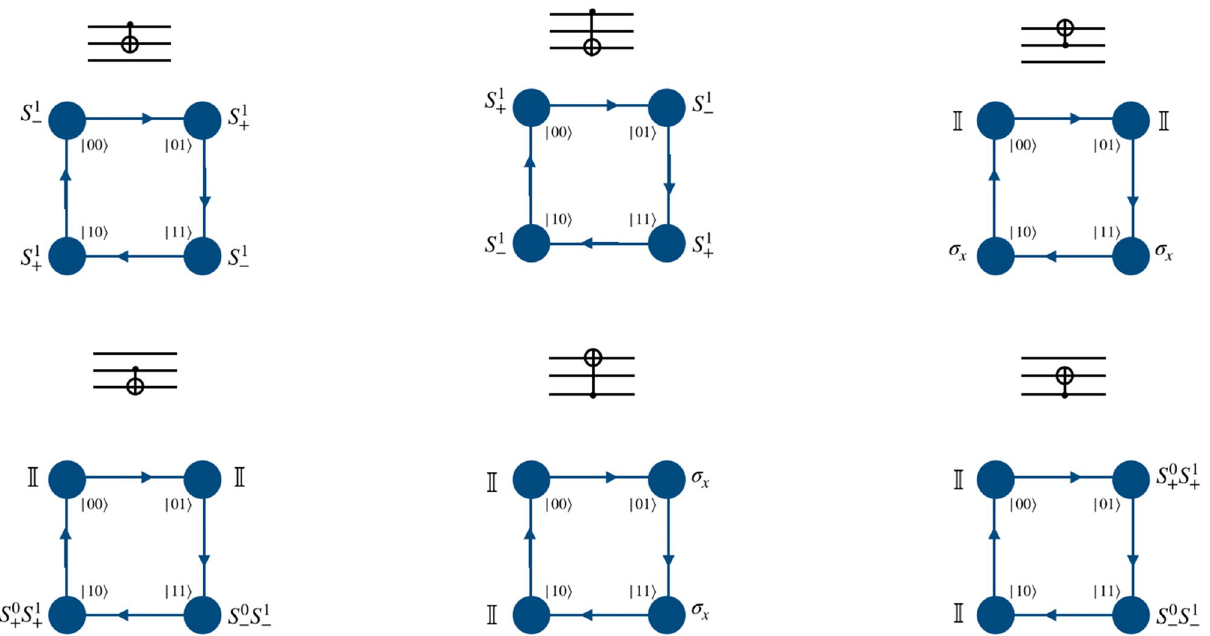
Figure 7. Schematic illustration of the controlled-NOT gate on the computational basis of three-qubit system using position-dependent quantum walk operators. Form of the shift operator S